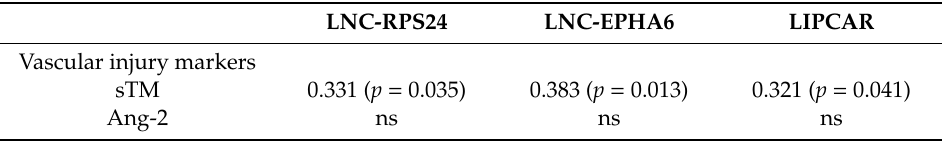
Table 2. Correlation of lncRNAs with vascular injury markers sTM, Ang-2. Values represent correlation coe ffi cient and p